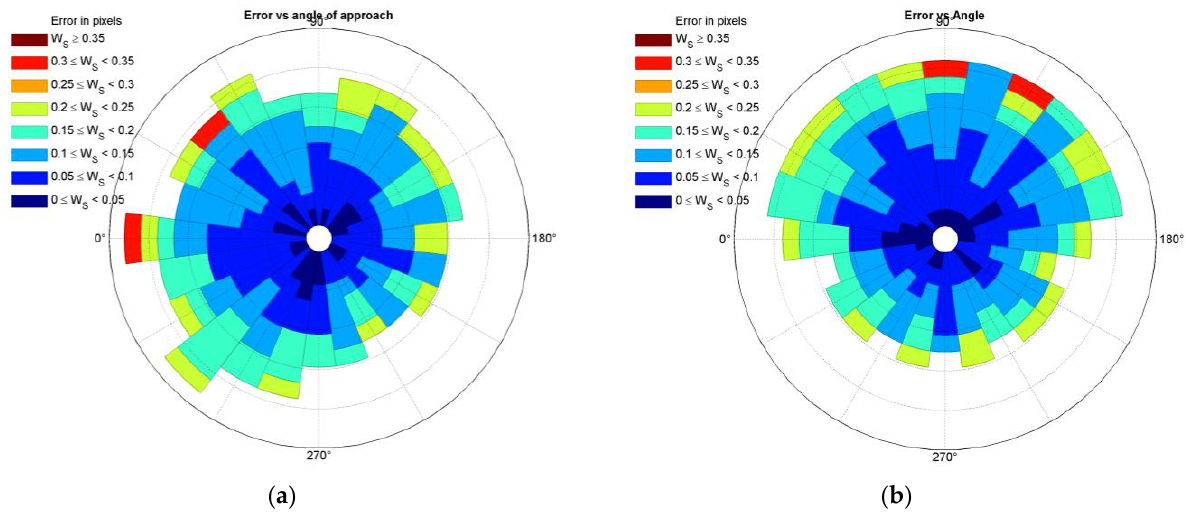
Figure 9. Rose plots of gaze error vs. angle of approach: ( a ) pre-task and ( b ) post-task.